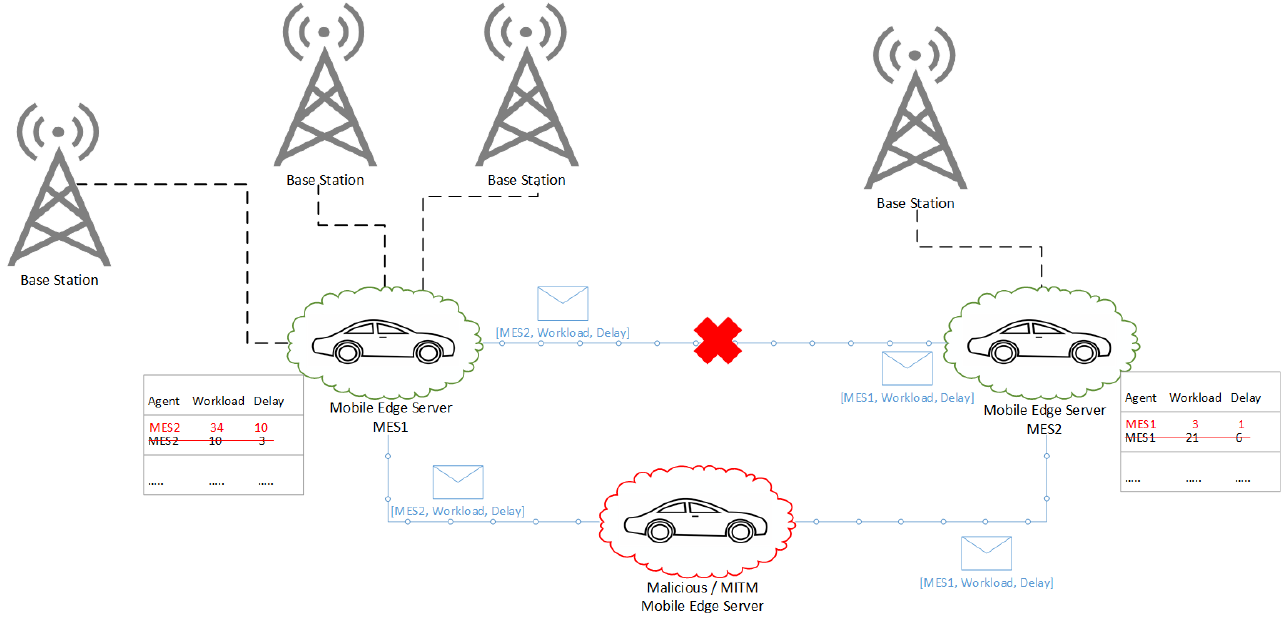
Figure 9. Malicious/MITM Agent scenario at a Mobile Edge